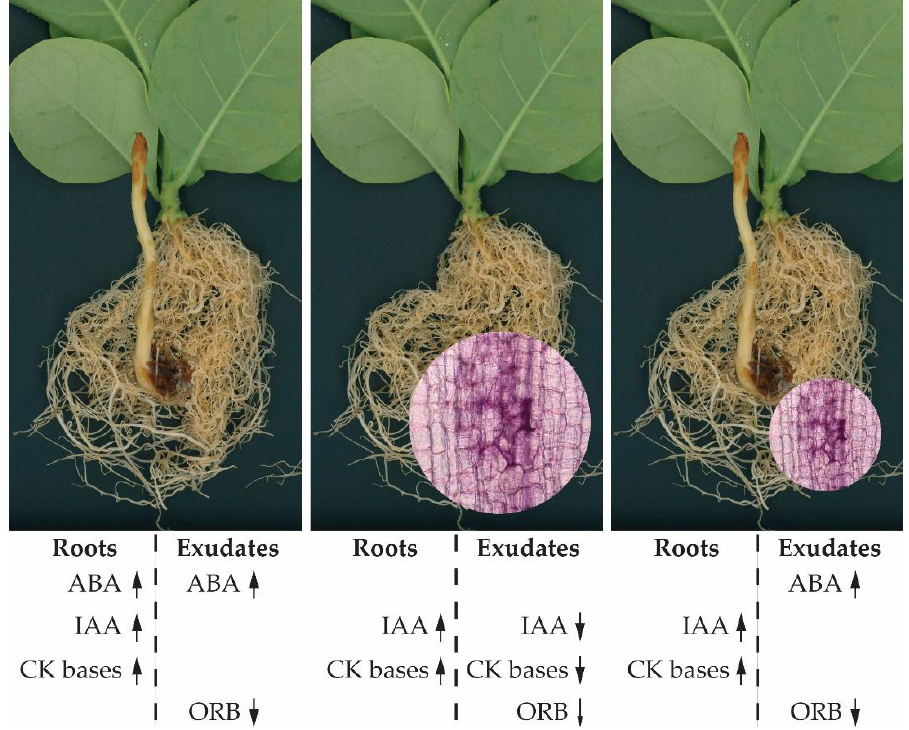
Figure 7. Overview of the host plant-parasitic plant-AM fungi interactions associated with plant hormone regulation. Shown are characteristic trends in the levels of endogenous and exuded hormonal species found in this study. Upwards and downwards arrows depict an increase or decrease in the hormonal content, respectively (the thinner arrow next to ORB in exudates of mycorrhizal plants represents mild reduction without statistical significance). Note the weaker root colonization with R. irregularis in broomrape-infested tobacco plants.